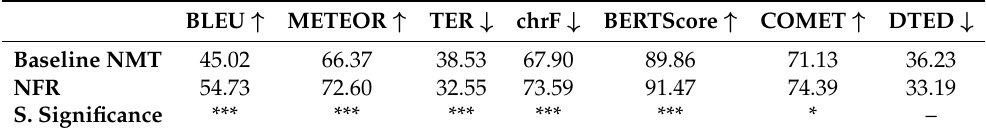
Table A1. Automatic evaluation results for the subset of the test set which was used for error annota- tion and the level of statistical significance of the differences per metric (* p < 0.05; *** p < 0.001).